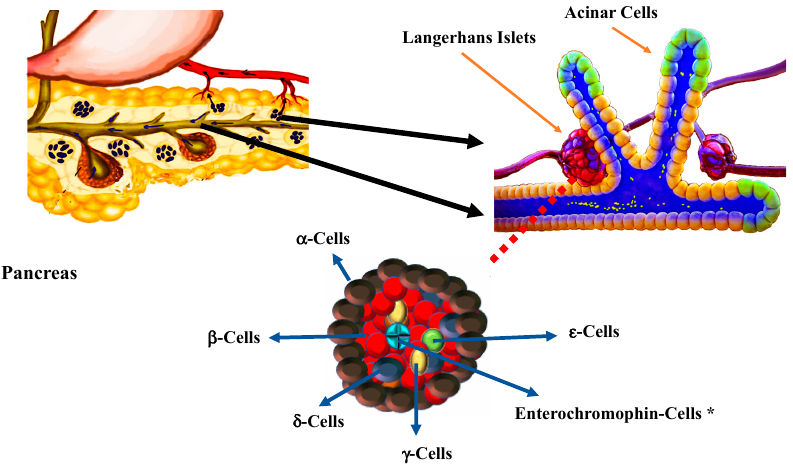
Figure 2. The pancreas has two main functions. As an exocrine organ, it secretes enzymes to digest proteins, carbohydrates and fats. The endocrine component of the pancreas consists of islets of Langerhans that create and release hormones directly into the bloodstream. Pancreatic endocrine cells are clustered into islets of Langerhans, which are composed of different functional cells. The endocrine pancreas consists of 5 main types of secretory cells, alpha cells ( α -cells), which express glucagon; beta cells ( β -cells), which express insulin; delta cells ( δ -cells), which express somatostatin; gamma cells ( γ -cells), which express pancreatic polypeptide; and epsilon cells ( ε -cells), which express ghrelin. In adults, 60% of islet cells are β -cells, and 30% are α -cells. Different types of endocrine cells establish a paracrine network and interact with peptides involved in an autocrine-mediated hormone secretion. * Enterochormaphin cells have been described in human in vitro β -cells differentiation [91].